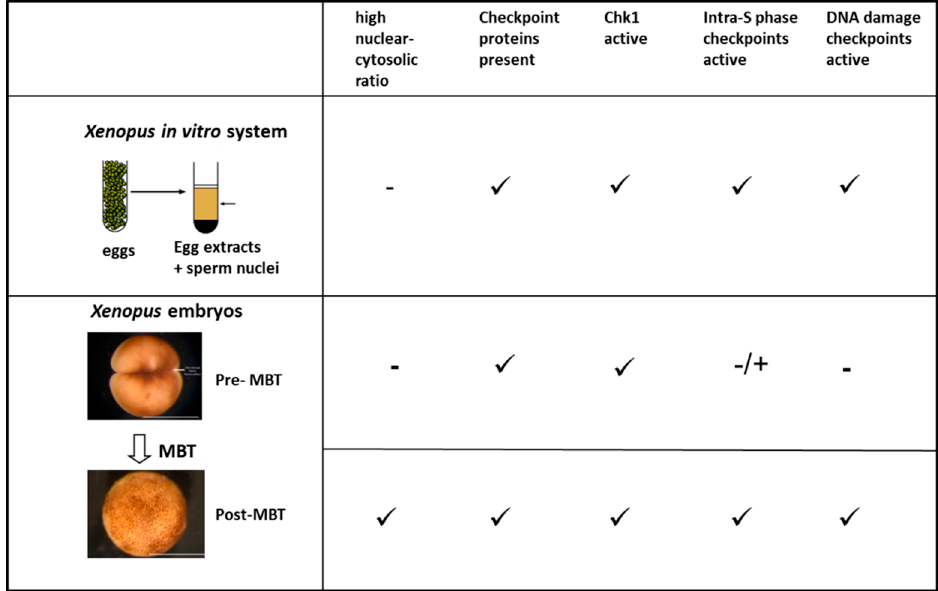
Figure 3. Comparison of checkpoint responses in the Xenopus in vitro system, in pre- and post-mid-blastula transition (MBT) Xenopus embryos. Photos of Xenopus embryos are from Xenbase [167].